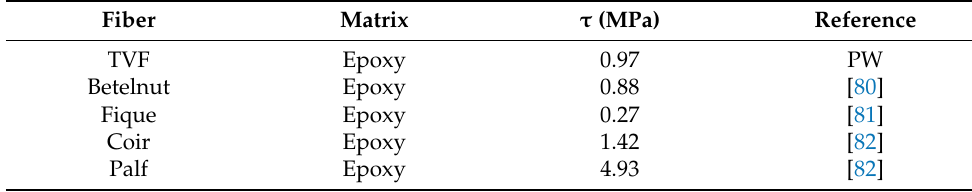
Table 8. Comparison of interfacial shear strength for different NLFs.